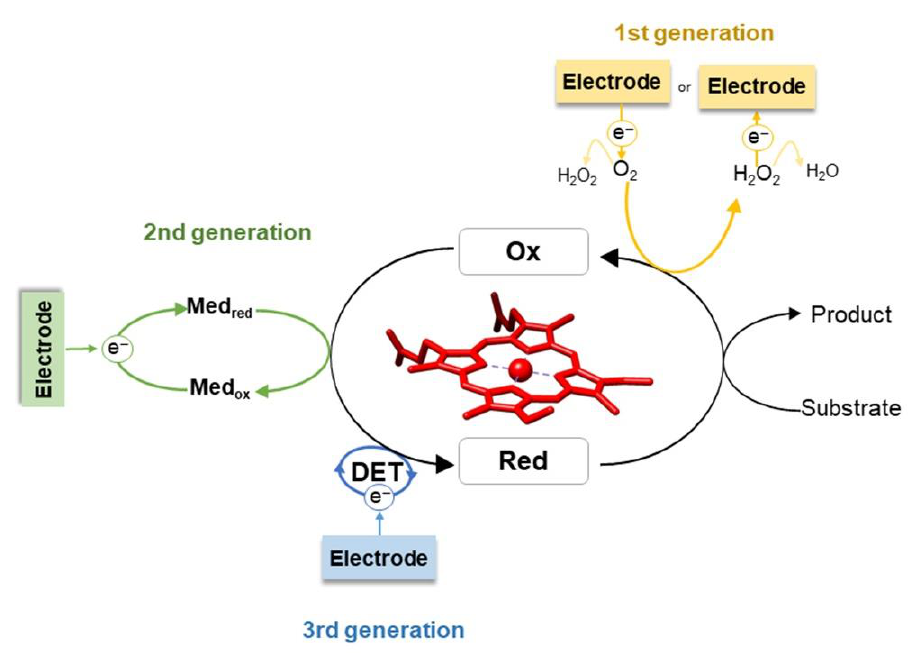
Figure 1. Schematic representation of different electron transfer (ET) modes in amperometric enzyme biosensors. The depicted examples show the reduction process of the enzyme. In first-generation biosensors (yellow), the co-substrate (O 2 ) or product (H 2 O 2 ) of the enzymatic reaction are detected directly at the electrode. In second-generation biosensors (green), the amperometric signal arises from the reduction of the mediator following ET to the enzyme. Third-generation biosensors (blue) measure the direct reduction of the enzyme redox center by the electrode. Med—mediator; Red—reduced; Ox—oxidized; DET—direct ET.